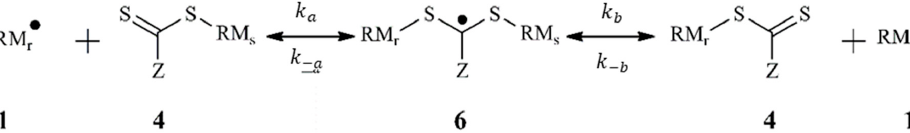
Figure 3. Chain equilibration (addition–fragmentation).